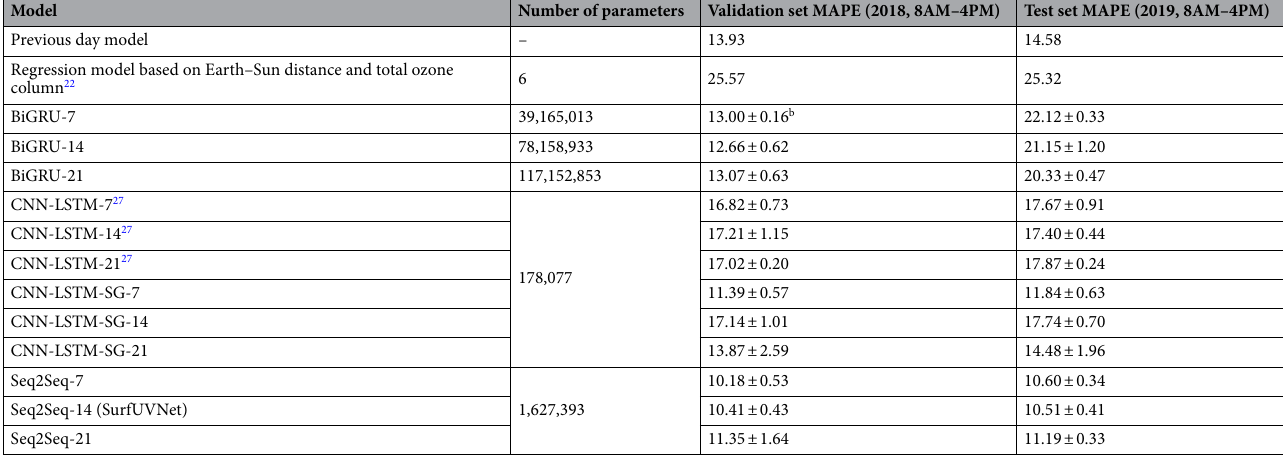
Table 1. Mean absolute percentage errors (MAPE) of the next-day antipsoriatic irradiance forecasting produced by SurfUVNet and benchmark models on Nakhon Pathom dataset.